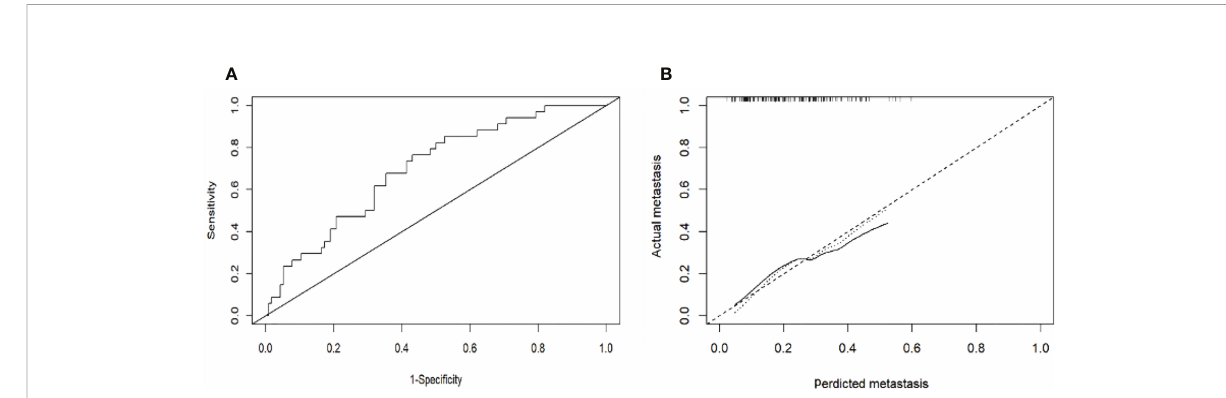
FIGURE 5 (A) : Receiver operating characteristic curves for EHM of the patients in the validation cohort. The receiver operating characteristic curves at the initial diagnosis are shown, and its area ROC curves are provided. (B) : Calibration plots of EHM in the validation cohort. The calibration curves derived from the validation cohort are almost a diagonal line that would represent perfectly reliable prediction.